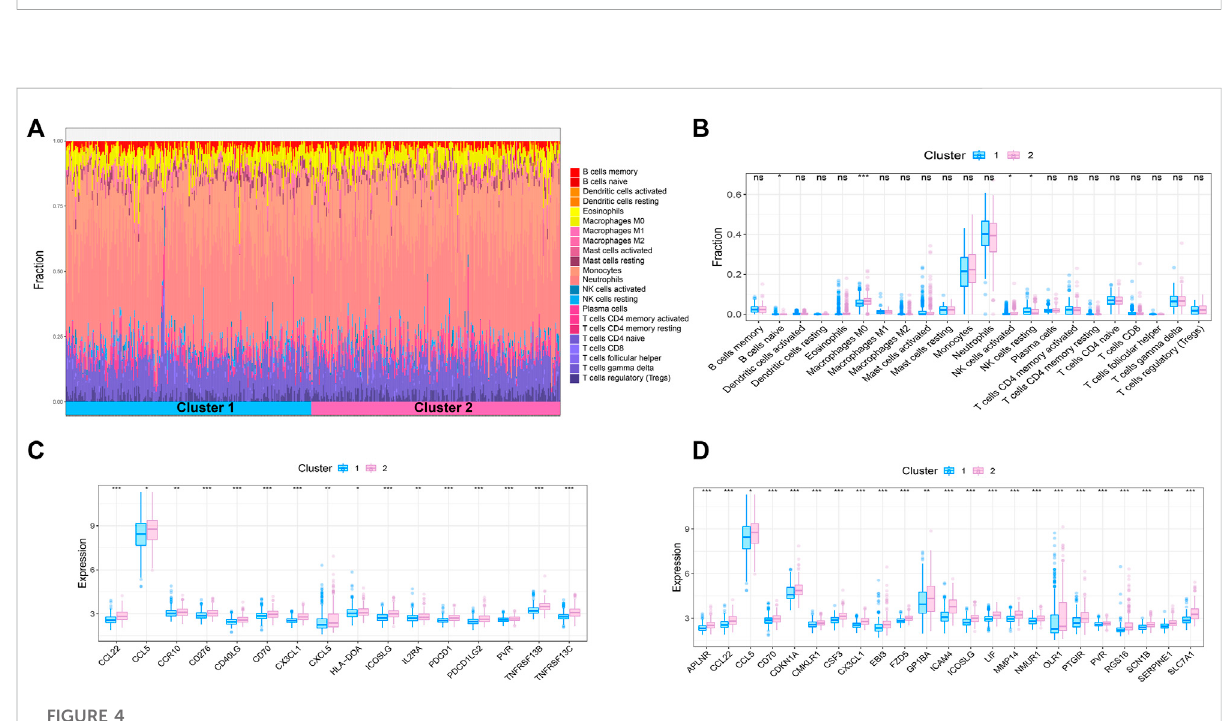
FIGURE 4 Immunemicroenvironmentanalysisofsepsis. (A) Thepercentageofeachimmunecellcontentwithinthesample (B) Thedifferenceofimmune cell content between subtypes, p < 0.05 was considered statistically signi fi cant. (C,D) Expression patterns of immune and in fl ammatory factors in